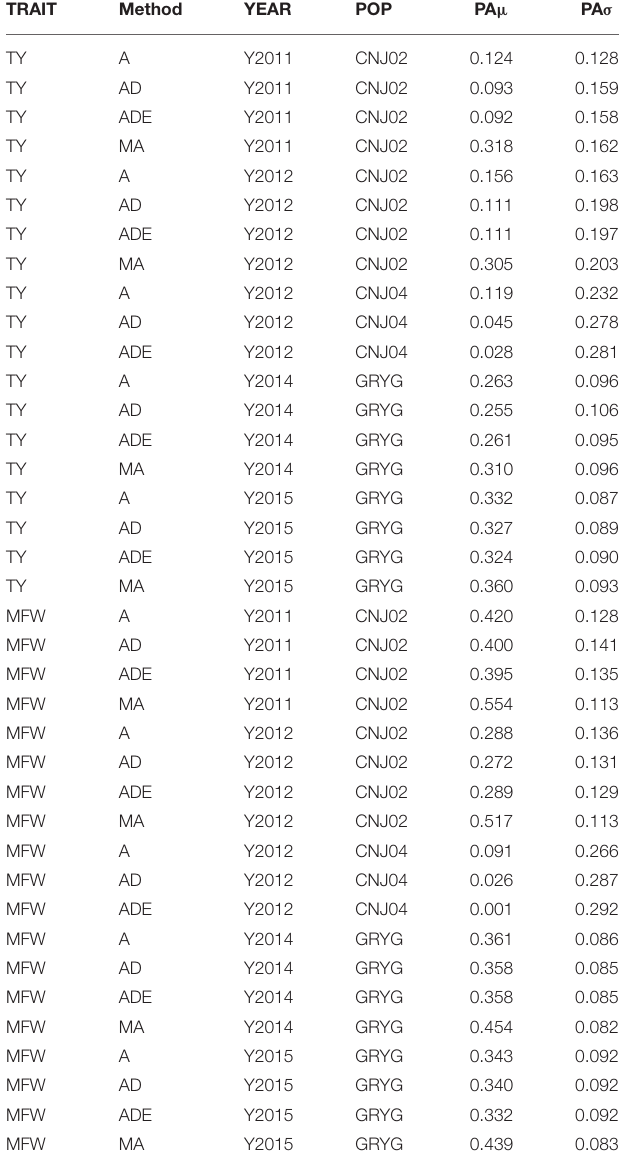
TABLE 3 | By-year comparison of four prediction methods (GBLUP-A, GBLUP-AD, GBLUP-ADE, MGBLUP) based on predictive abilities (and standard deviation) for total yield (TY) and mean fruit weight (MFW) in three biparental populations (CNJ02, N = 148; CNJ04, N = 67; GRYG, N = 351).